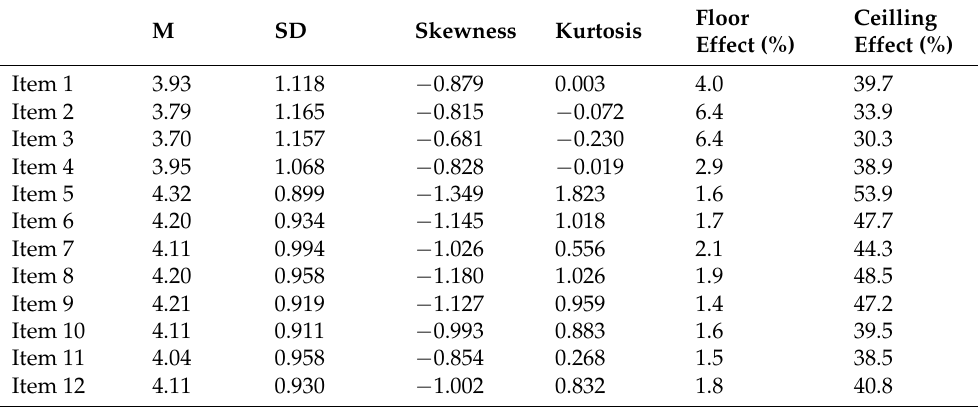
Table 2. Descriptive statistics, floor and ceiling effects for individual items (N =